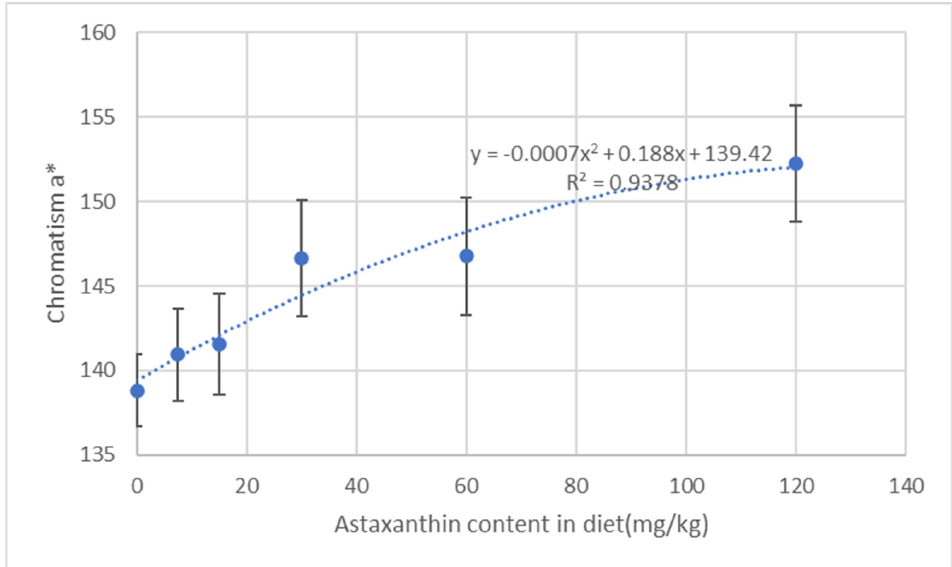
Figure 3. The relationship between the chromatism a* of shrimp and astaxanthin content in diet based on quadratic regression analysis.